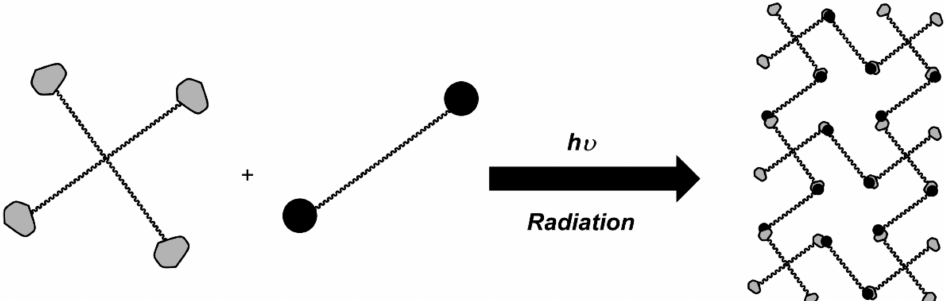
Figure 2. Representation of graft